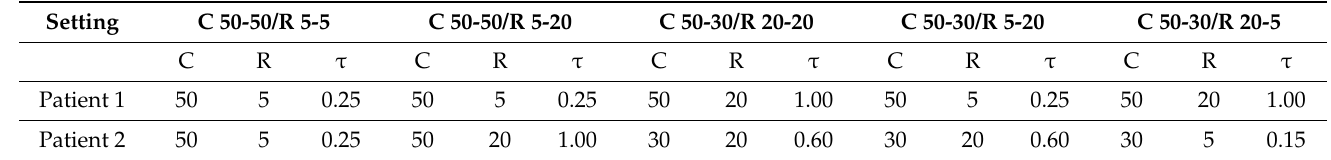
Table 1. Mechanical characteristics of the 2 “patients” in the 5 different settings tested in the study. C = compliance (mL